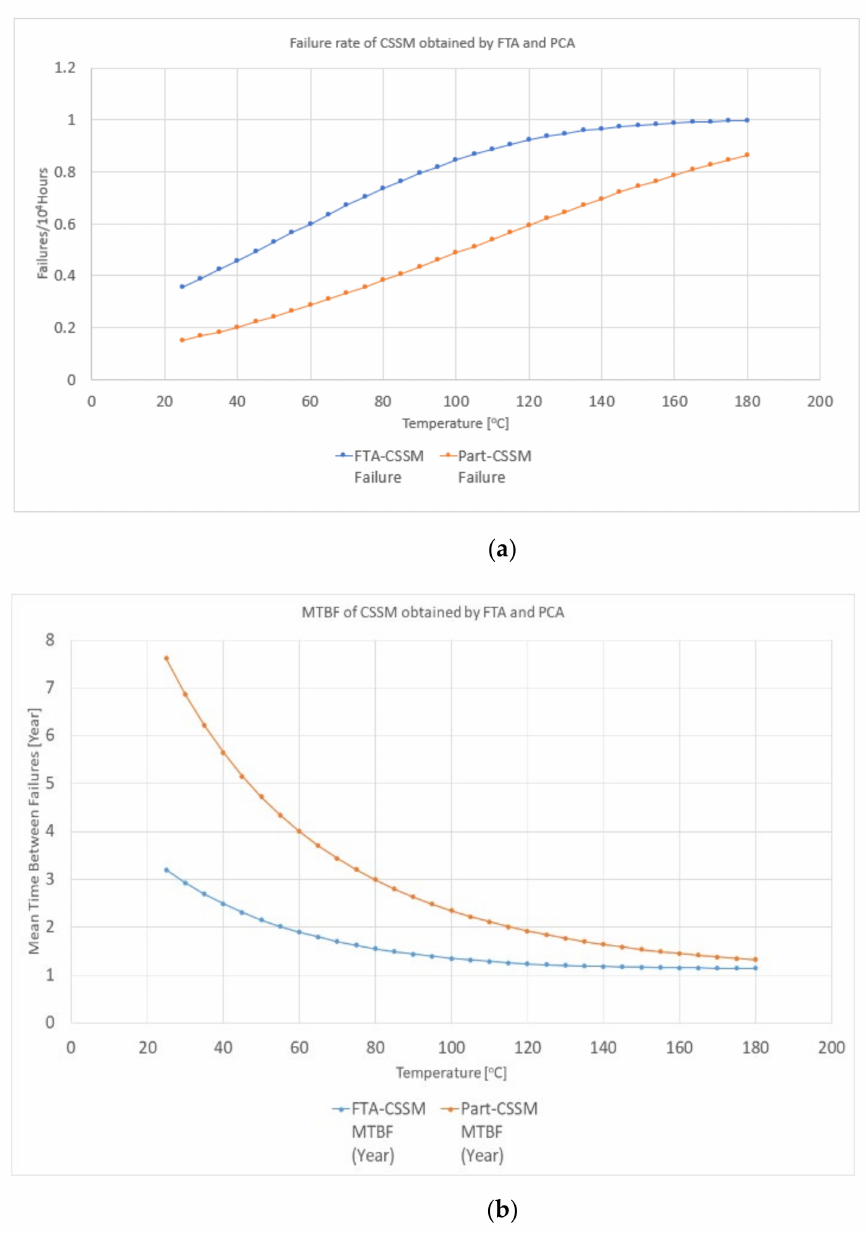
Figure 8. Comparison of failure rate and MTBF by PCA and FTA: ( a ) failure rate; ( b ) mean time between failures (MTBF),